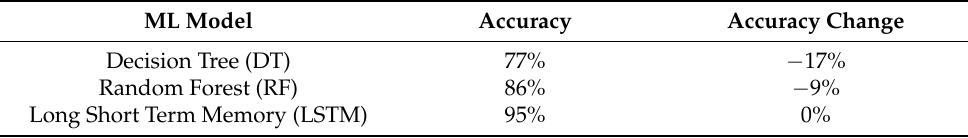
Table 4. Accuracies of ML classifiers for charging station classification with 10%